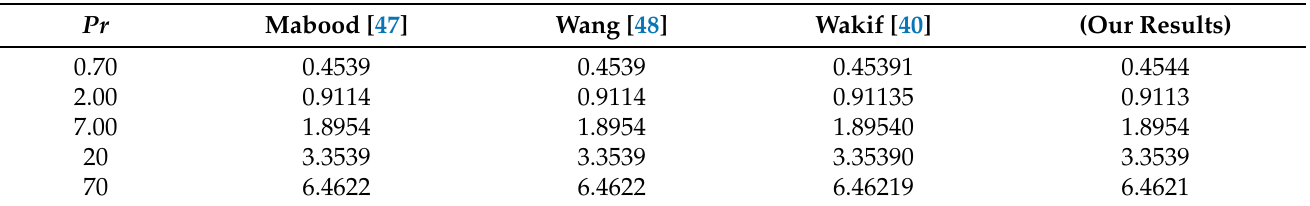
(cid:48)(cid:48) ( 0 ) , it is observed that local